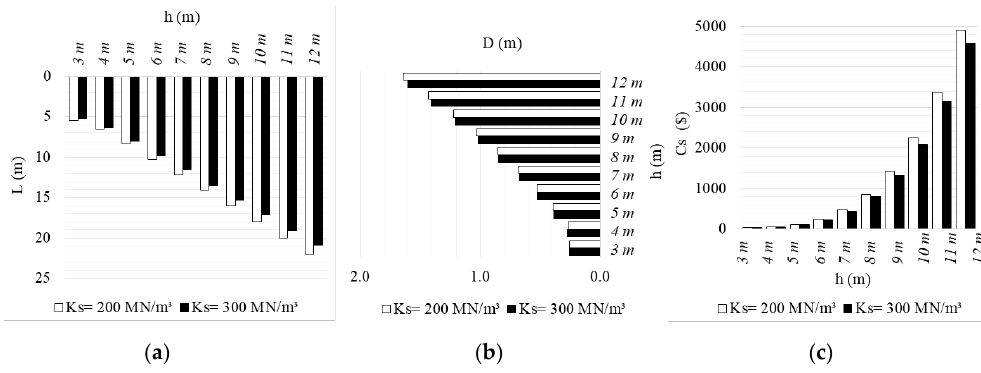
( c ) Figure 11. The effects of the change of external load to the diameter of the cantilever soldier pile ( a ), the length ( b ), and the unit cost of the pile ( c ) (for h = 6 m excavation depth) via the excavation depth. In Figure 12, the effect of the coefficient of soil reaction change is investigated. All analyses up to this part of the study were repeated for K S = 300 MN/m 3 . The coefficient of reaction can be identified as the preliminary effective parameter for the determination of the embedment depth of the soldier pile according to Equations (5) and (6). This parameter is inversely proportional to the length of embedment, so it is expected that the increase of coefficient of soil reaction from 200 MN/m 3 to 300 MN/m 3 shortens the pile length and/or straightens the diameter of the pile. This prediction is proven